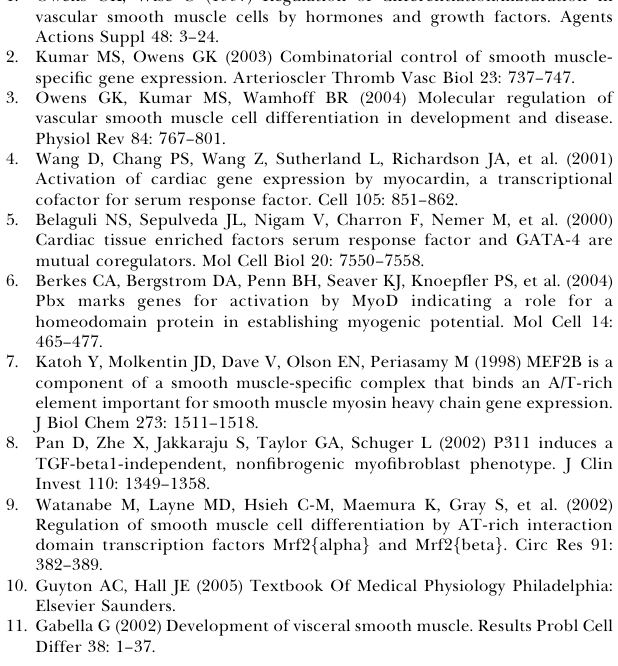
Figure S2. A Scatter Plot Showing the Relationship between the Hypoxia-Response [36] and the SMC Serum-Response Signatures in